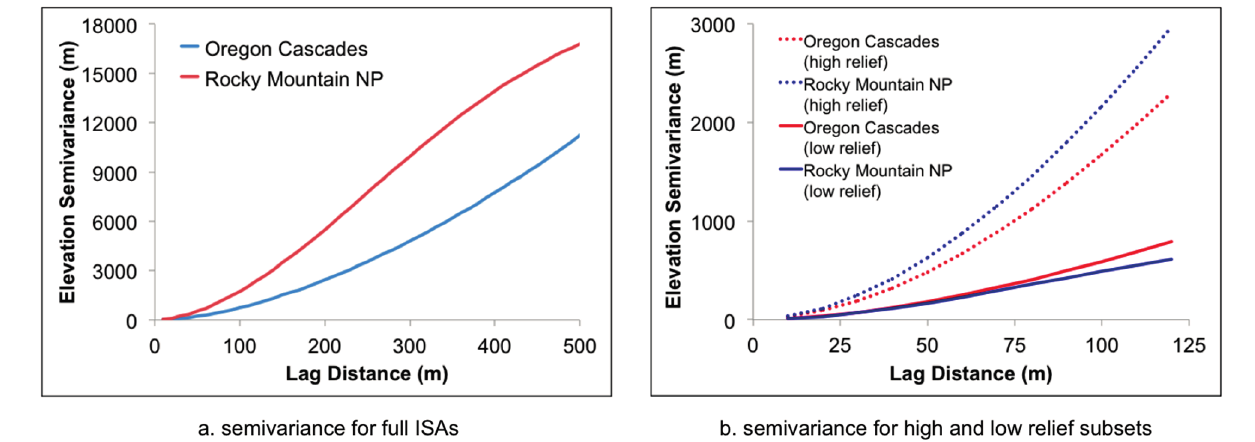
Figure 3. Semivariograms for elevation derived from 10 m DEM for ( a ) the Oregon Cascades and Rocky Mountain NP ISAs, and ( b ) high- and low-relief subsets from the Oregon Cascades and Rocky Mountain NP